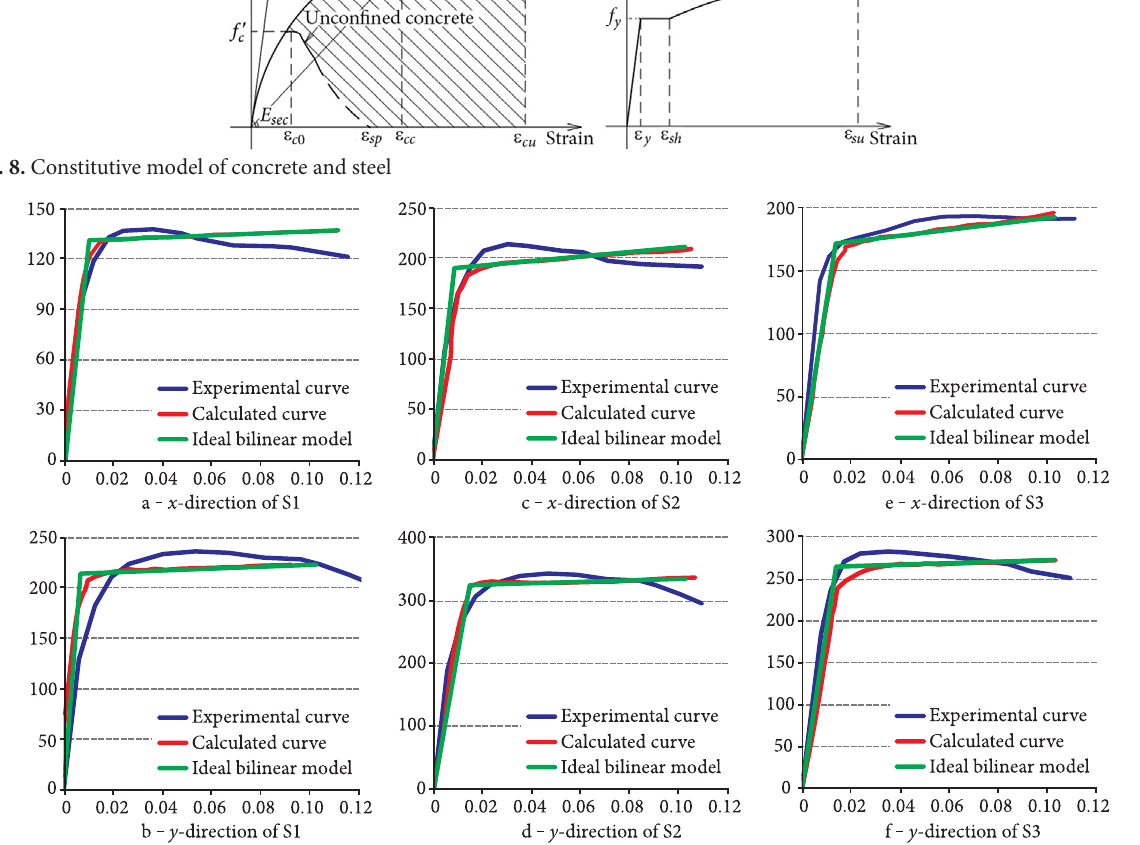
Fig. 9. Moment-curvature curves of